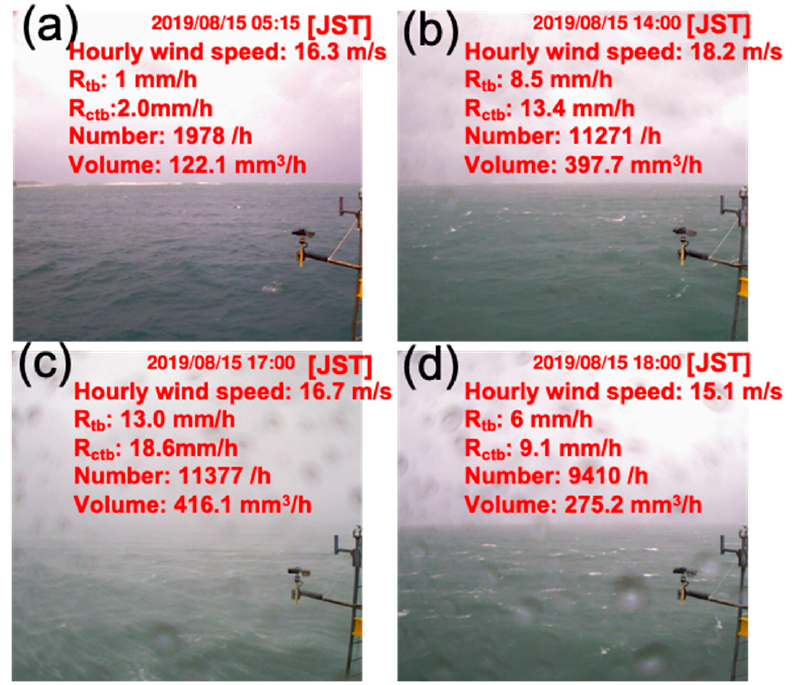
Figure 4. ( a – d ) Photographs of sea surface conditions at time points indicated by the arrows in Figure 3a–d.